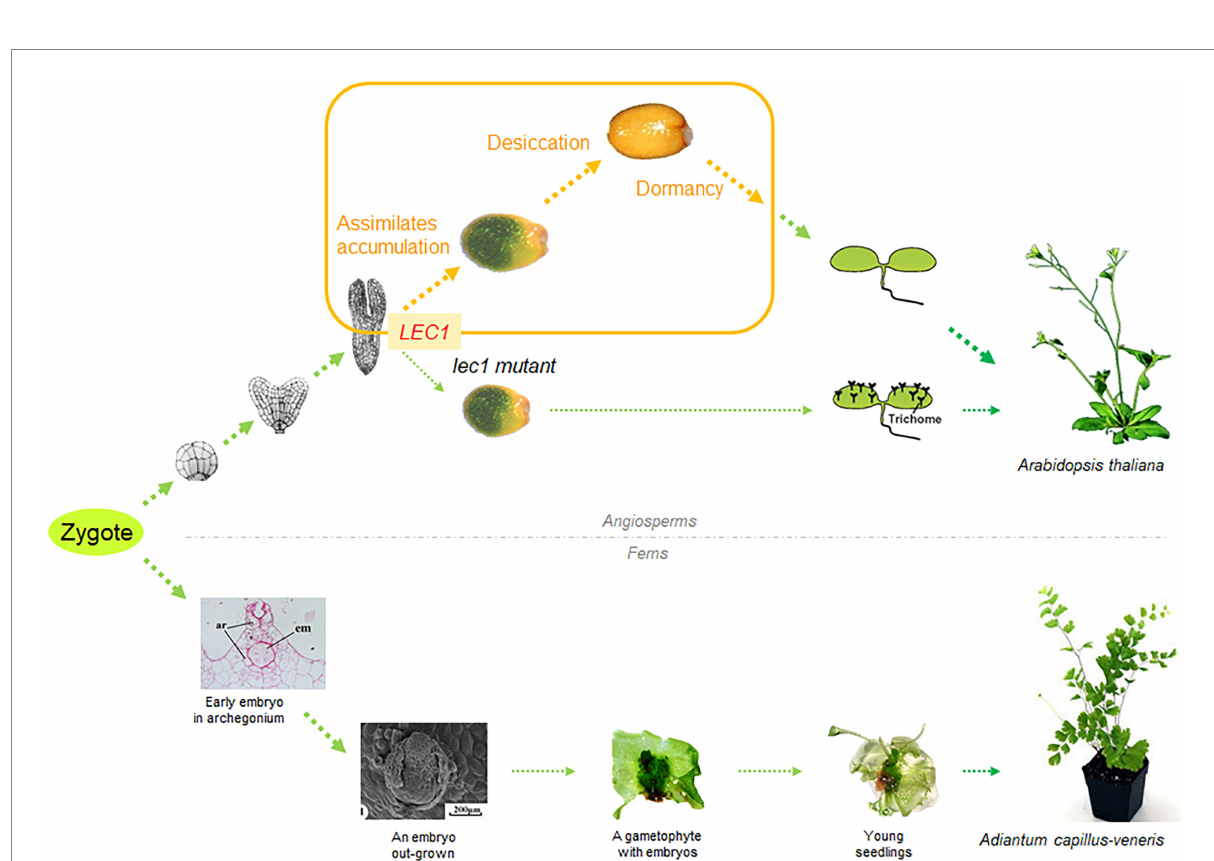
FIGURE 4 A comparison of early development, from zygote to seedling, between angiosperms and ferns. Angiosperms and ferns are represented by Arabidopsis and Adiantum capillus-veneris , respectively. The phenotype of the lec1 mutant during the embryogenesis resembles that of Adiantum capillus-veneris during early development. For a detailed morphological description of Adiantum capillus-veneris , see Li et al.